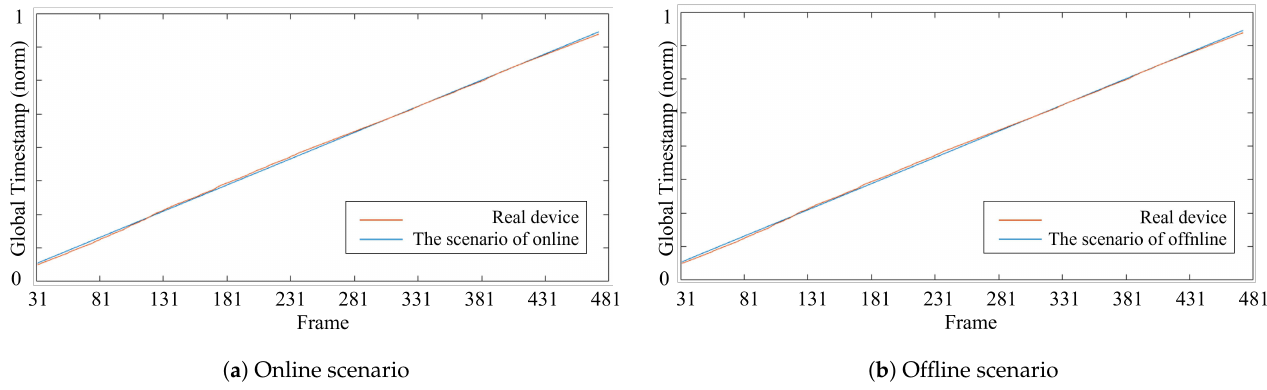
Figure 4. The global timestamps generated in ( a ) the online scenario and ( b ) the offline